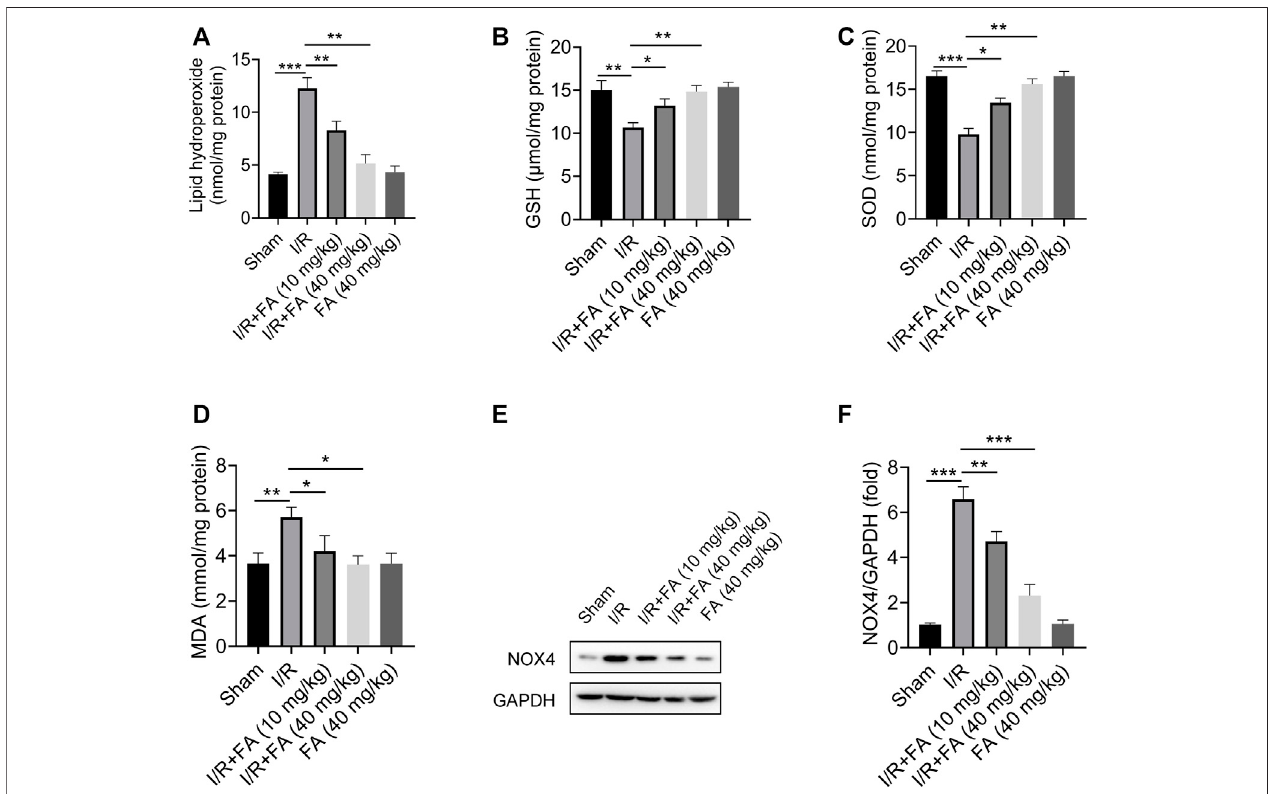
FIGURE 3 | Effect of FA on oxidative stress in the cardiac tissue homogenate. (A) Lipid hydroperoxide, (B) glutathione peroxidase, (C) superoxide dismutase, (D) malondialdehyde, (E – F) Western blotting analysis of NOX4 in the mice myocardium. Data are expressed as the mean ± SD from three independent experiments or are representative of three independent experiments. * p < 0.05, ** p < 0.01, and *** p < 0.001.